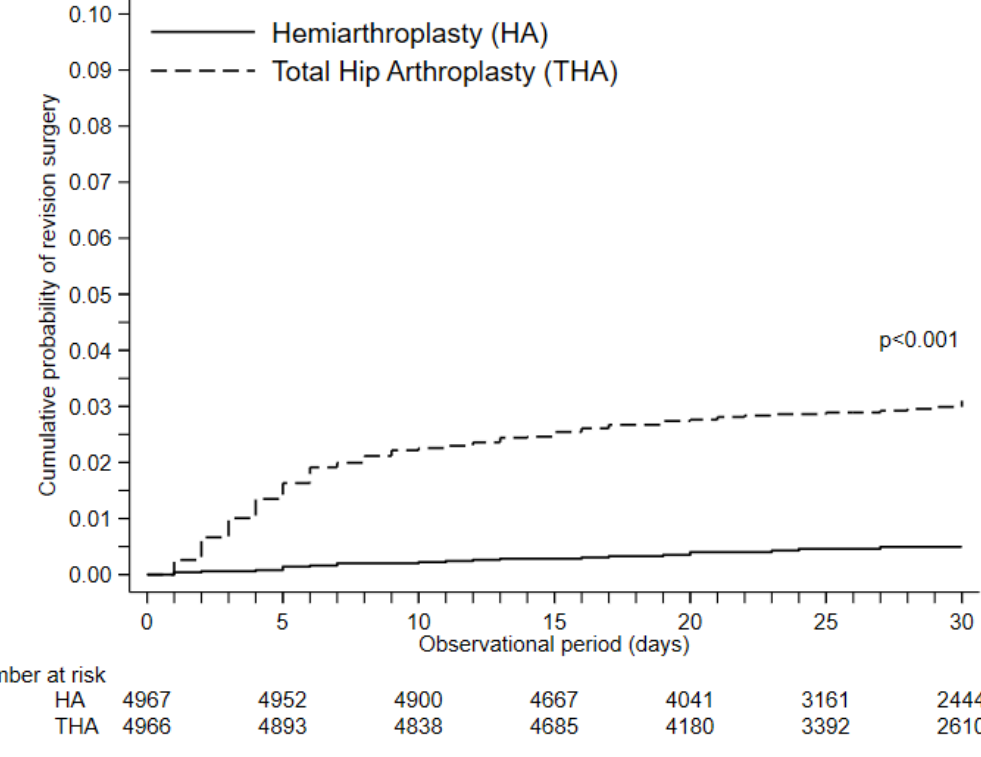
Figure 1. Kaplan–Meier curve of secondary revision surgery. The p -value of the log-lank test was <0.001.